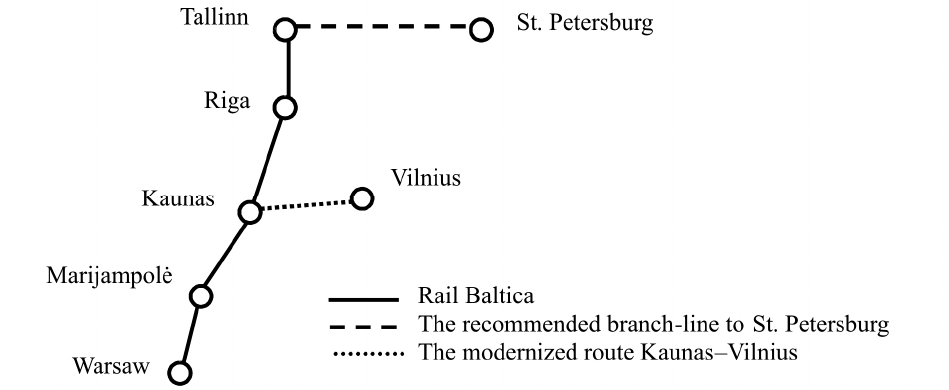
Fig 3. The “Rail Baltica” route with the Vilnius connection and the proposed branch-line to St.